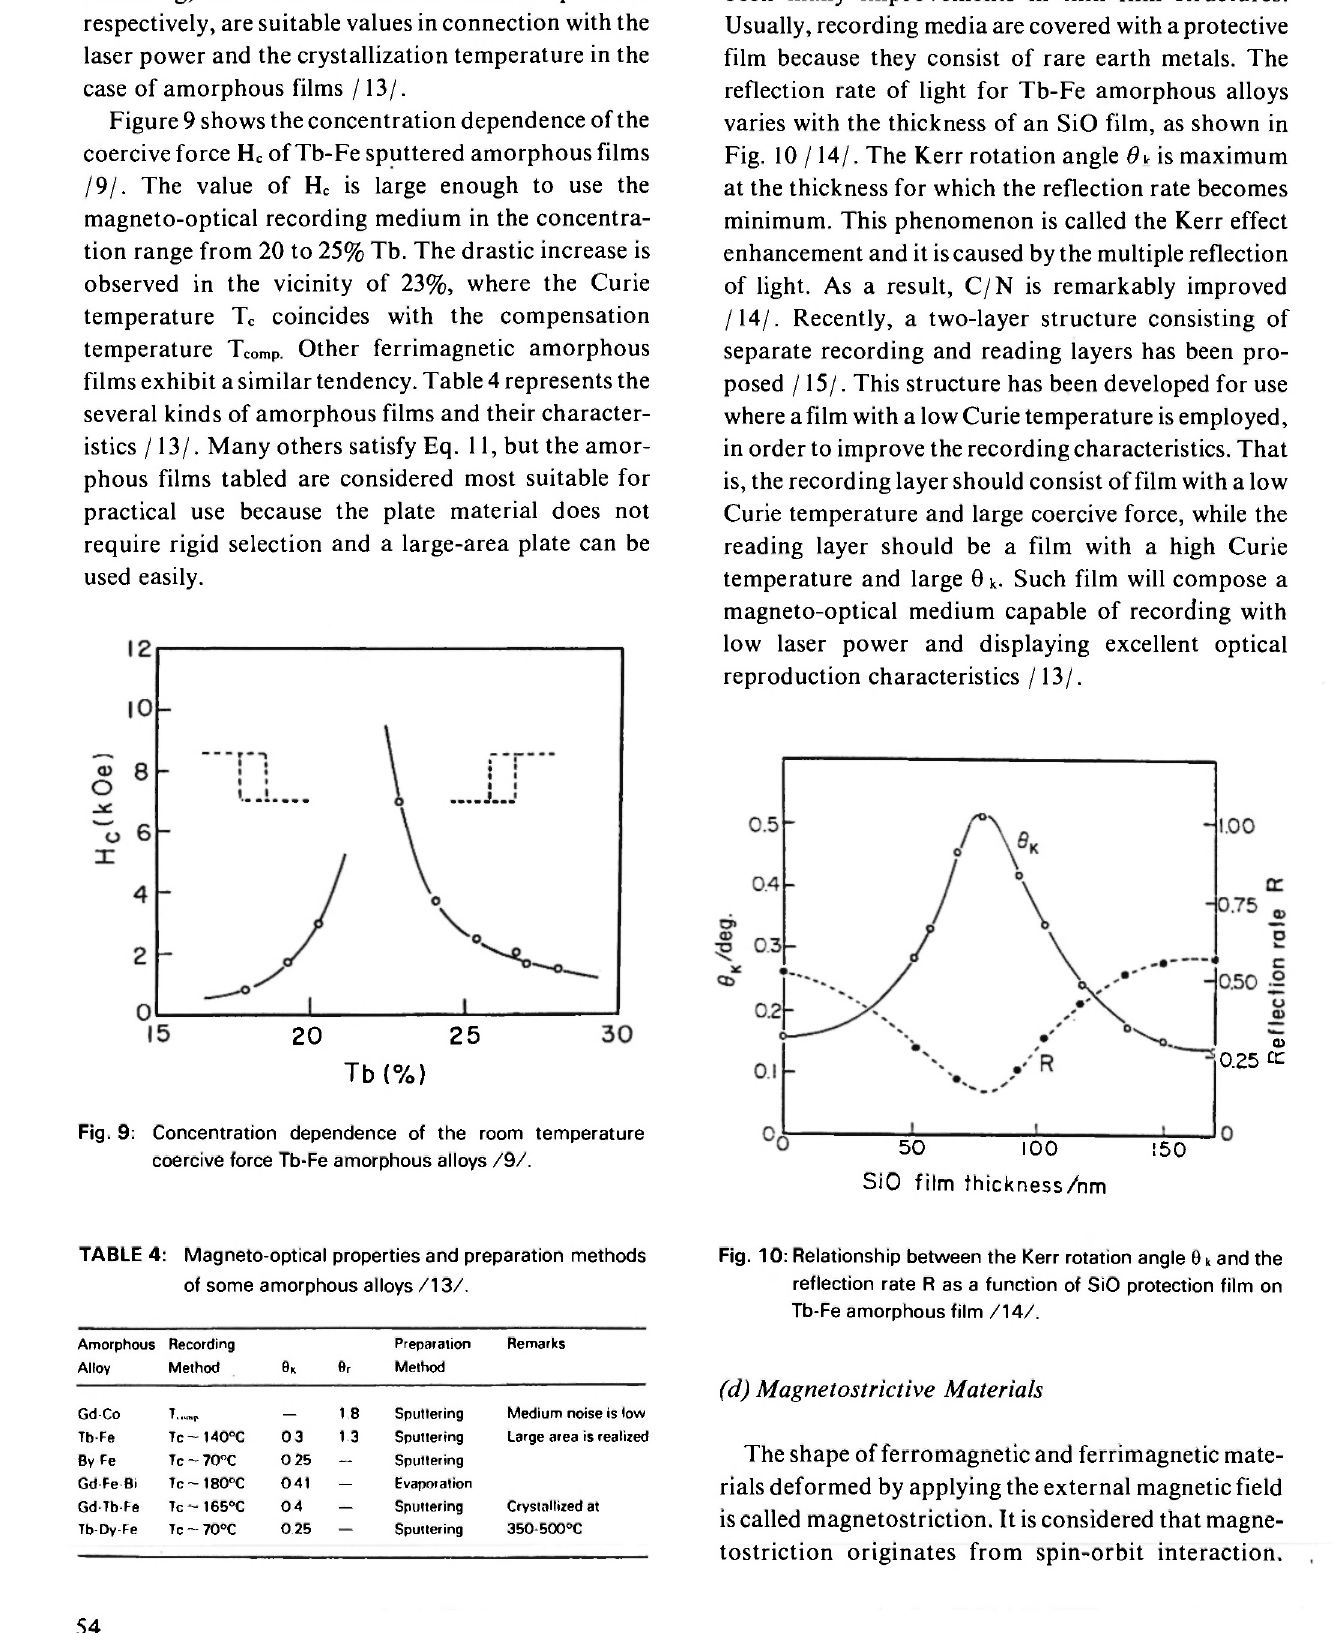
TABLE 4: Magneto-optical properties and preparation methods of some amorphous alloys /13/.